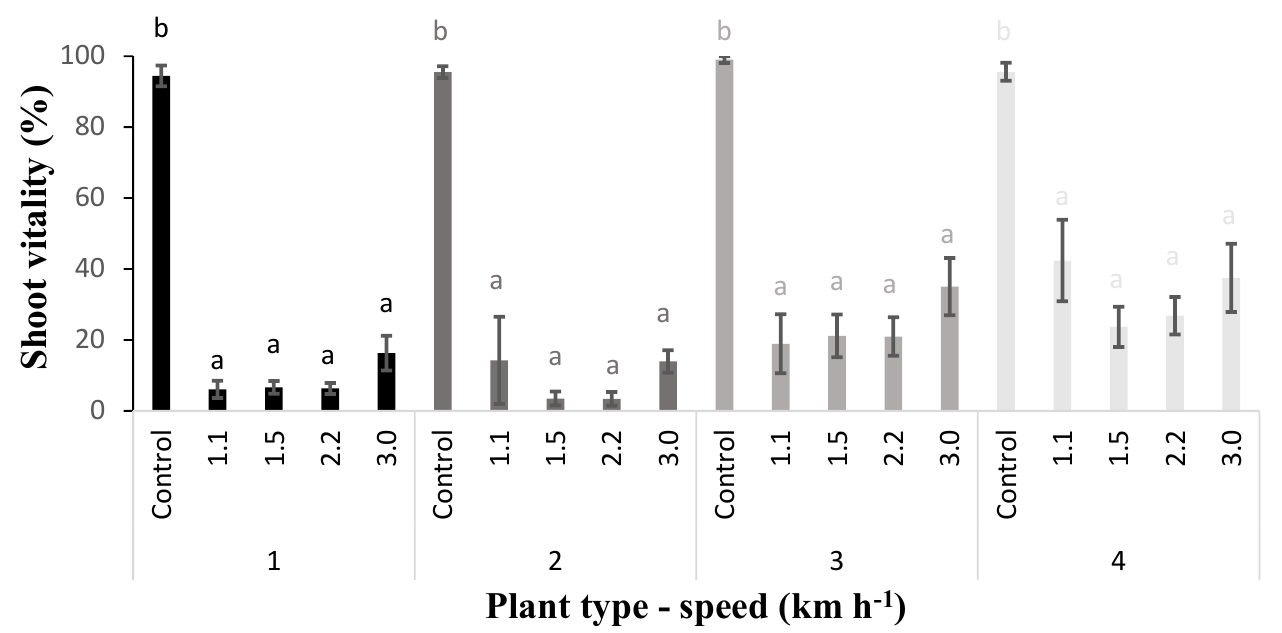
Figure 2. Shoot vitality (%) of electrocuted C. esculentus plants for each combination of plant type and speed (km·h − 1 ) in the Zasso experiment at Bree in 2021. Means sharing the same letter are not significantly different ( p < 0.05); comparison within plant type only.